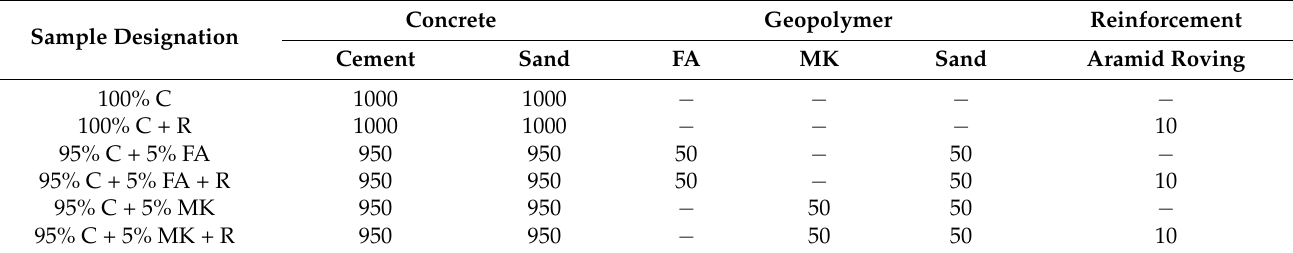
Table 2. Composition of concrete and concrete–geopolymer hybrids samples (kg/m 3 ).